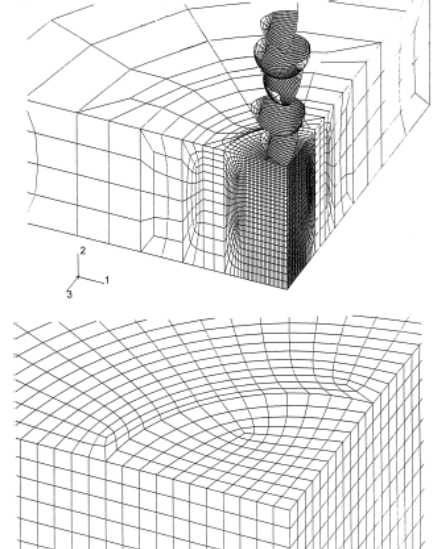
Fig. 3. 3D finite element model for the determination of resi-